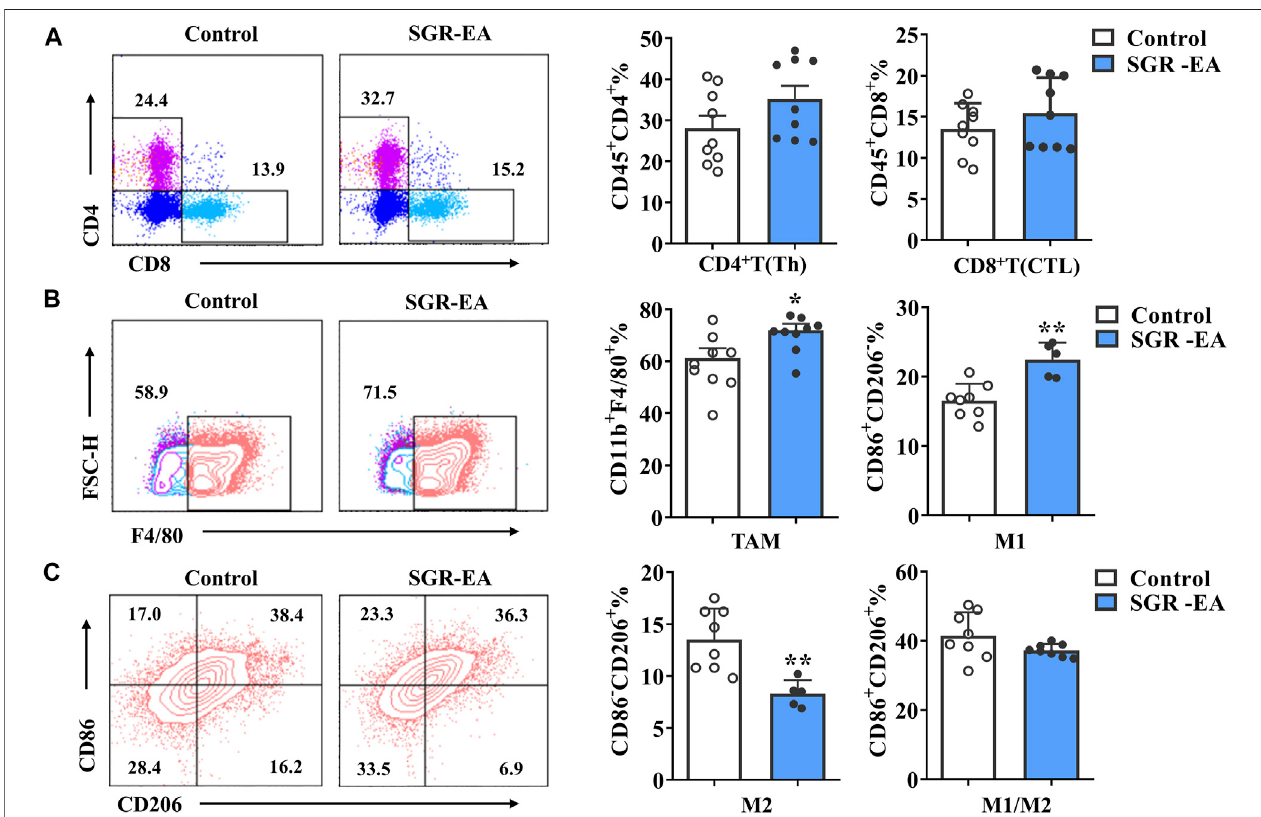
FIGURE 3 | SGR-EA treatment improved the immune microenvironment of breast cancer. (A) CD4 + T cells (CD45 + CD4 + ) and CD8 + T-cell (CD45 + CD8 + ) expressionsinthetumor. (B,C) TAM(CD11b + F4/80 + )expressions inthe tumor;M1 (CD11b + F4/80 + CD86 + CD206 − ),M2(CD11b + F4/80 + CD86 − CD206 + ),and M1/M2 (CD11b + F4/80 + CD86 + CD206 + ) expressions in the tumor. Unless otherwise denoted, n ≥ 5 for each group, and data are presented as means with error bars denoting SD. * p < 0.05 and ** p < 0.01 versus control.